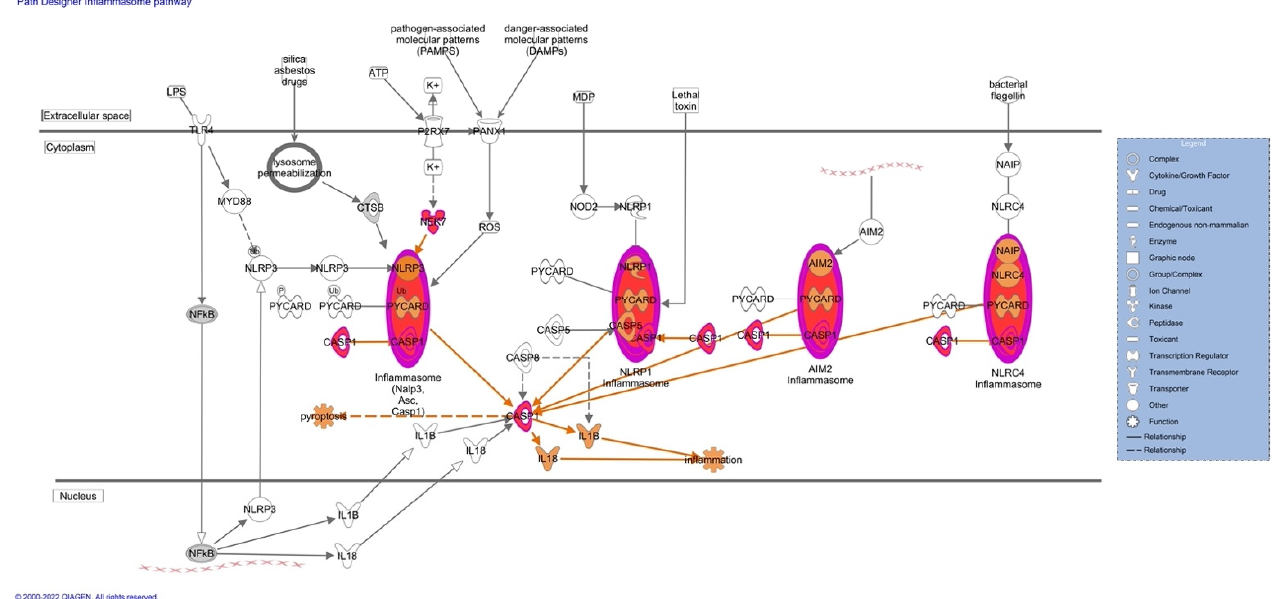
Figure 3. Inflammasome pathways of differentially expressed proteins from ZIKV-positive and negative placentas. Prediction legend: the intensity of red corresponds to higher upregulation of the protein. These proteins are caspase-1 (CASP1), serine/threonine-protein kinase Nek7 (NEK7) and ubiquitin-associated protein 2-like (Ub). The color grey means that the protein was identified but there was no significant increase in expression. Proteins in orange in the diagrams were not detected by our proteomics experiments. The orange means predicted activation of the protein or interaction leading to activation. The protein gene name is used in the diagrams. To identify proteins, refer to Supplementary Table S1’s gene name column. Data were analyzed using IPA (QIAGEN Inc., Hilden, Germany, https://www.qiagenbioinformatics.com/products/ingenuitypathway-analysis; accessed 15 September 2022).